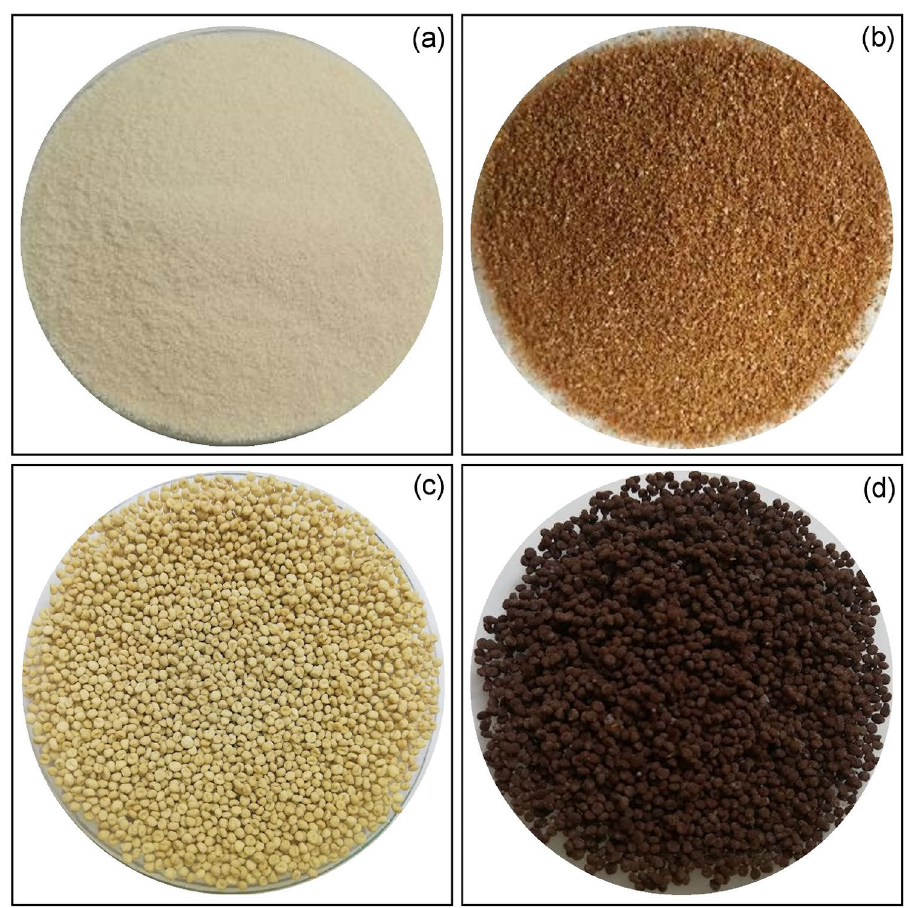
Figure 1. The physical characteristics of ( a ) sugarcane bagasse powder (SB), ( b ) sugarcane bagasse powder doped iron(III) oxide-hydroxide (SBF), ( c ) sugarcane bagasse powder beads (SBB), and ( d ) sugarcane bagasse powder doped iron(III) oxide-hydroxide beads